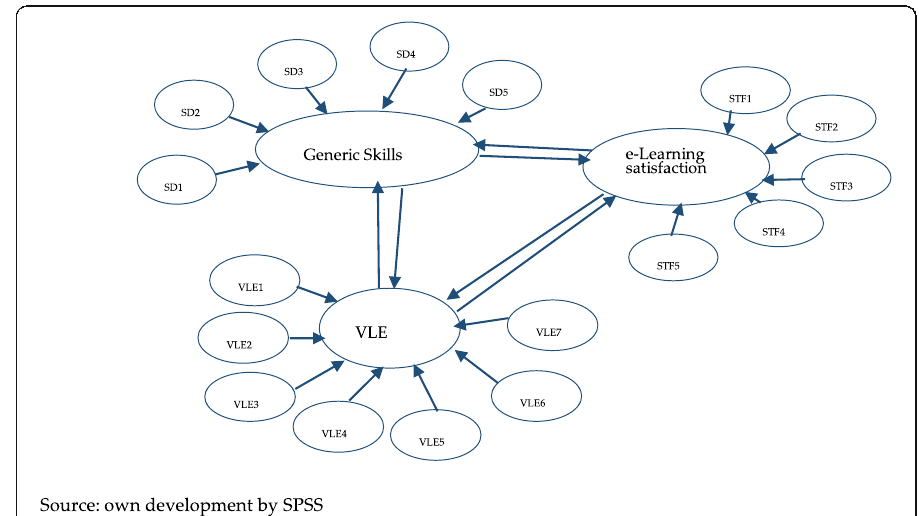
Fig. 2 Model. Source: own development by